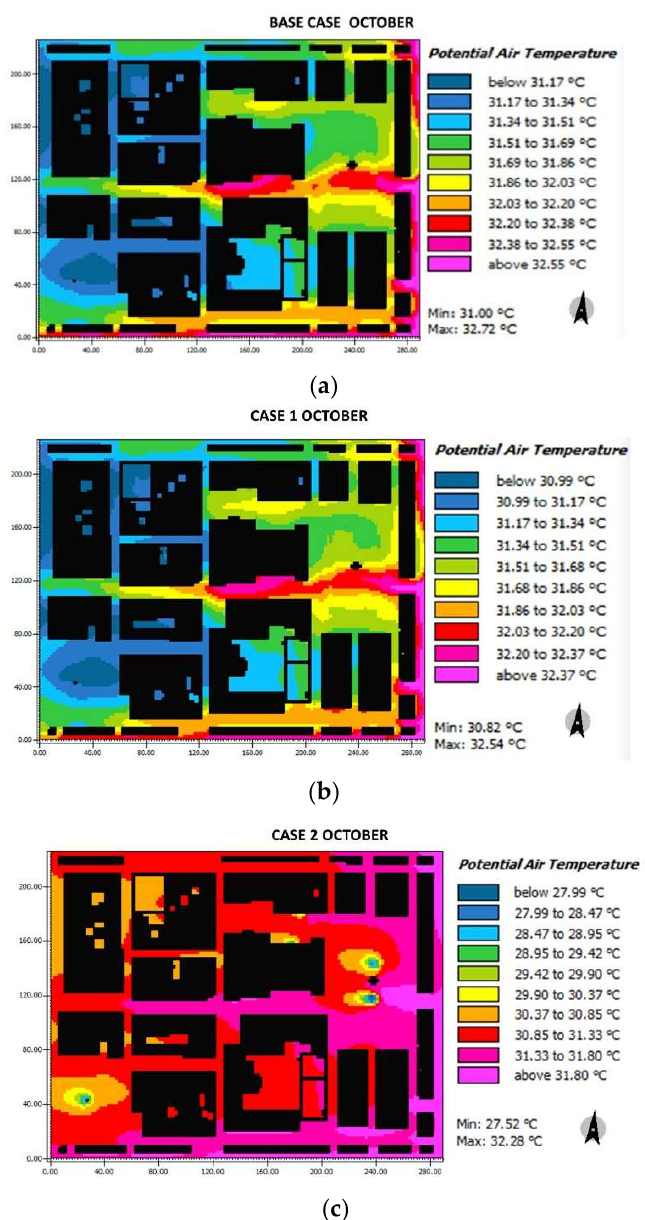
Figure 12. Results maps for potential air temperature for October at 15:00: ( a ) base case, ( b ) case 1, and ( c ) case 2.